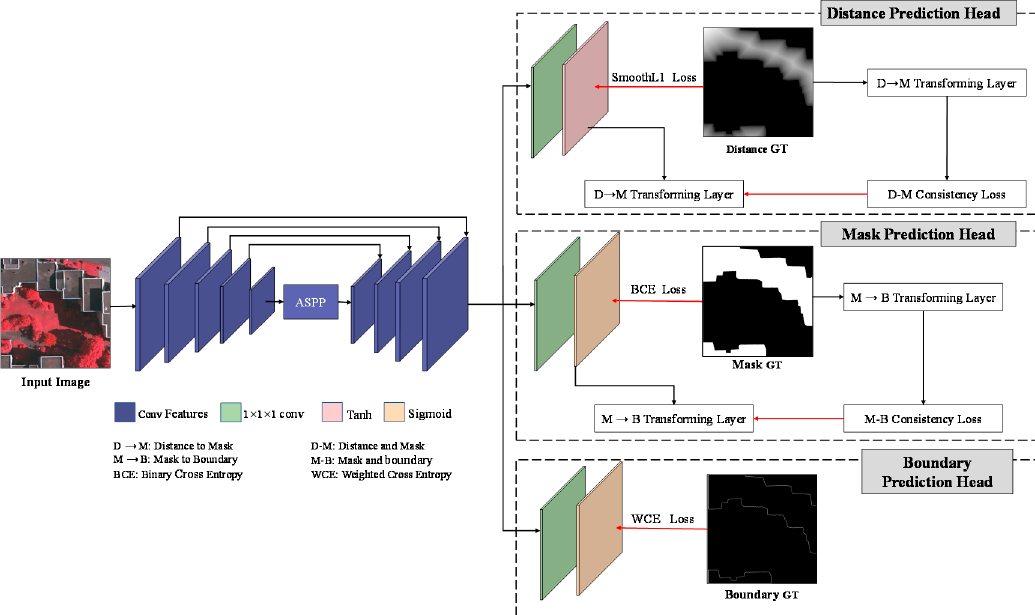
Figure 3. Overall framework of the proposed method.